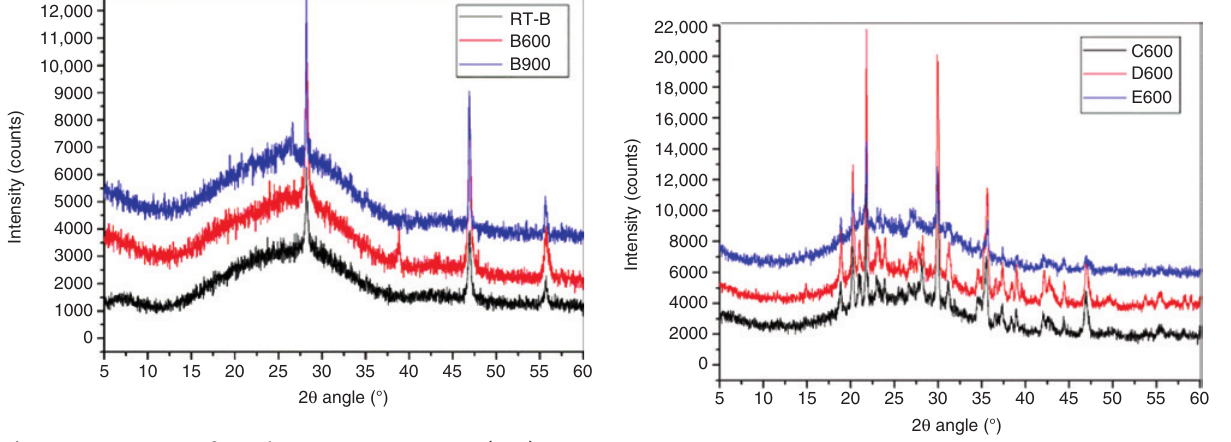
Figure 5: XRD pattern of sample B at room temperature (RT-B), B600 and B900.